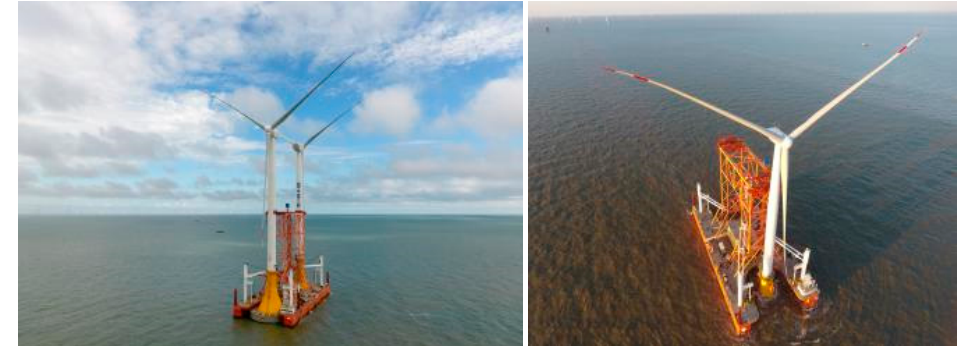
Figure 2. Jiangsu Dafeng 6.45 MW prototype .